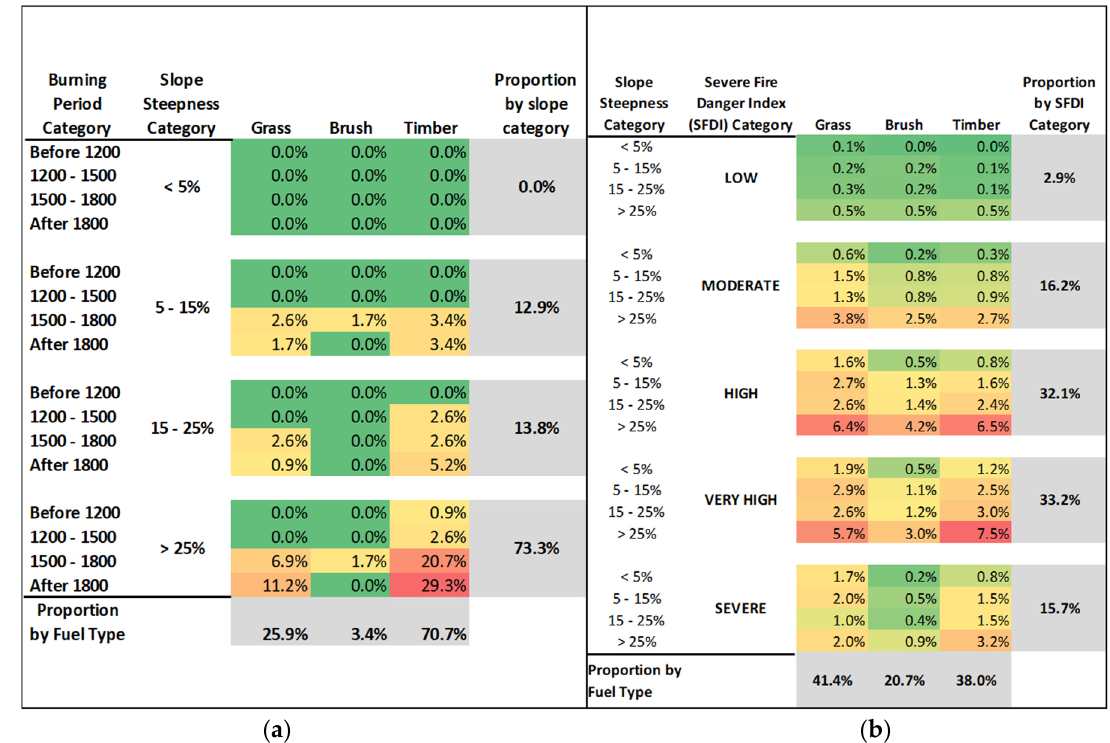
Figure 7. Drop condition matrix examples. Proportional totals are displayed according to a green to red (low to high) color gradient scale to visually highlight those cells with the highest proportional totals. ( a ) Proportion of total drop events for an example incident categorized by slope steepness category (by percent slope), majority fuel type (grass, brush, and timber), and time of day as a coarse proxy for potential fire behavior. ( b ) Proportion of total drop events for a regional scale analysis where drops are categorized by slope steepness, majority fuel type, and Severe Fire Danger Index (SFDI) daily values.